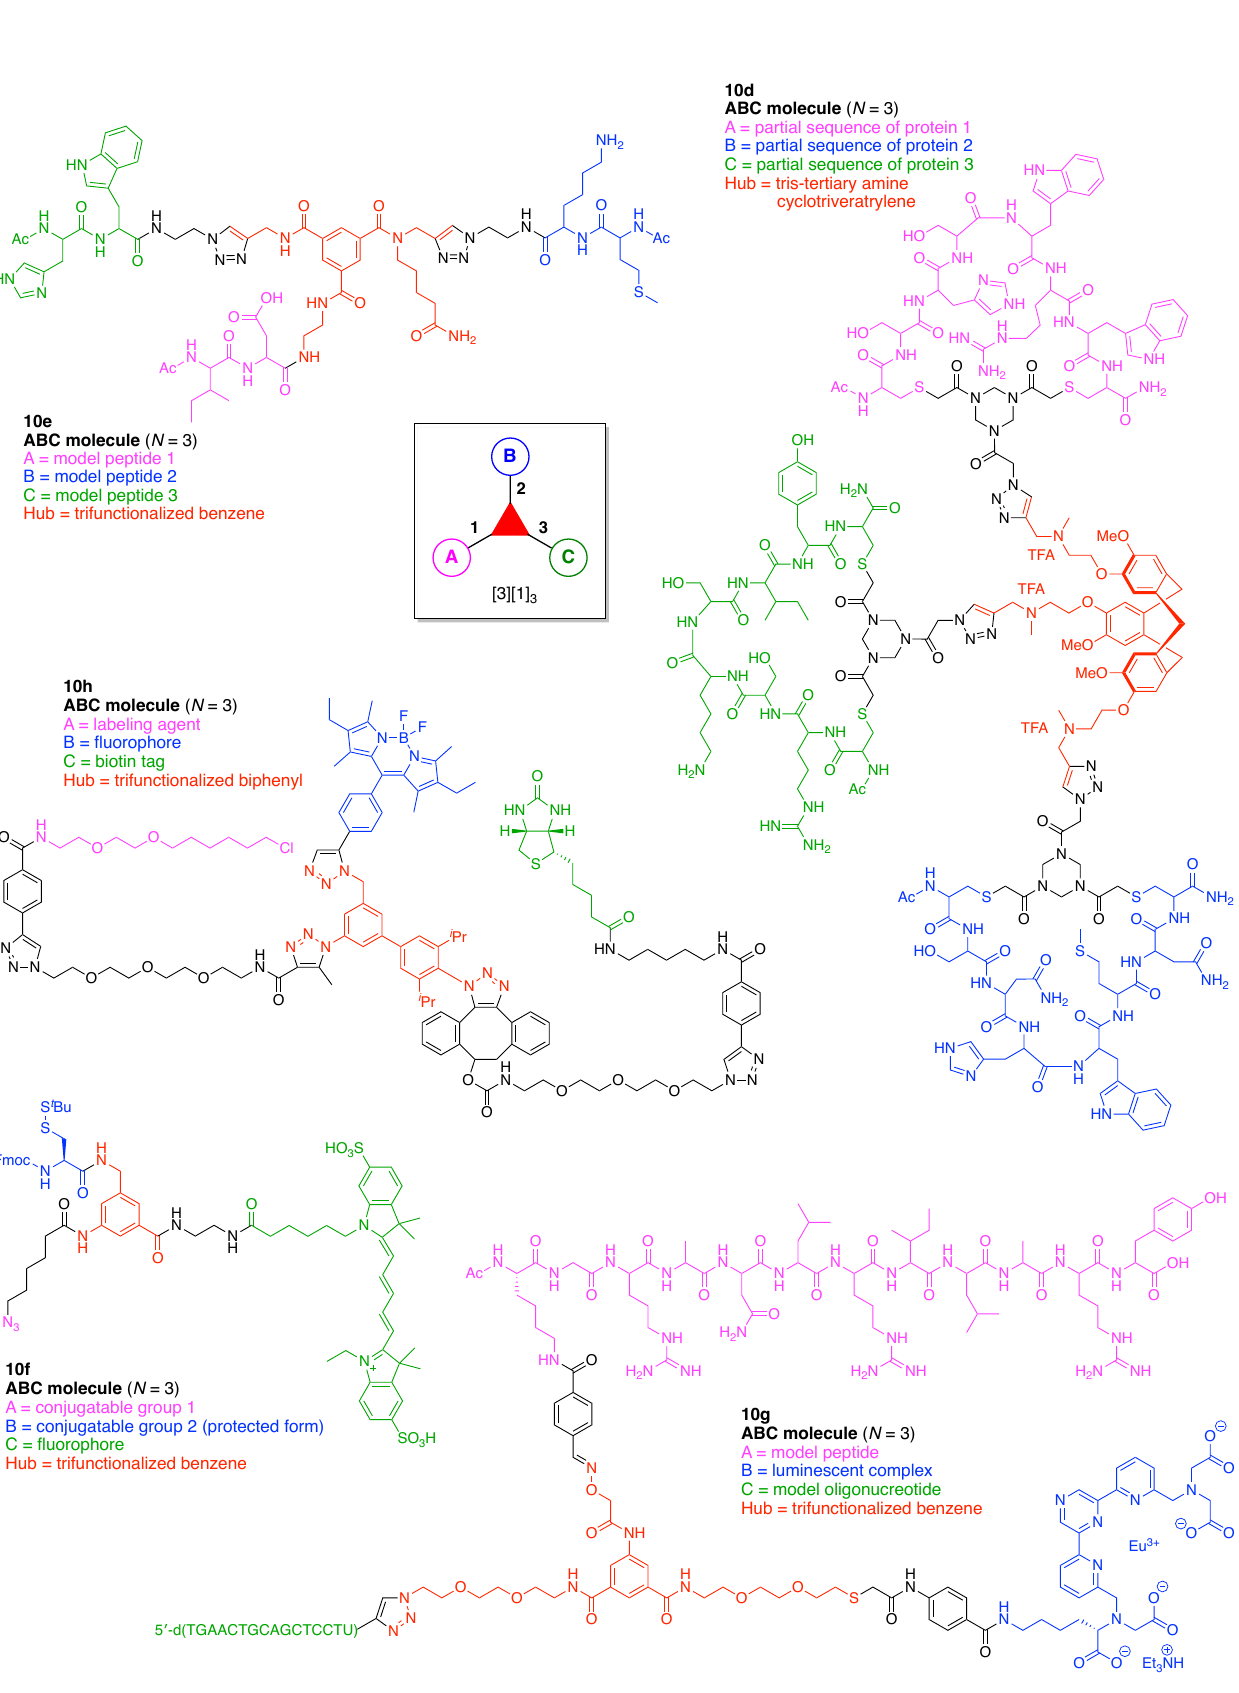
Figure 44. Examples of single benzene hubs. A luminescent peptide–oligonucleotide model conjugate ( 10g ) was developed on the basis of a heterotrifunctional benzenic scaffold equipped for multiple bioconjugations